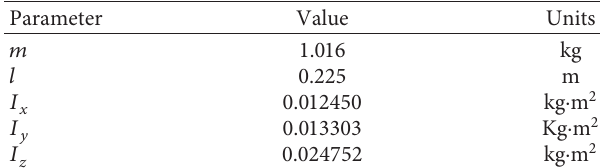
Table 2: Parameters of the quadrotor